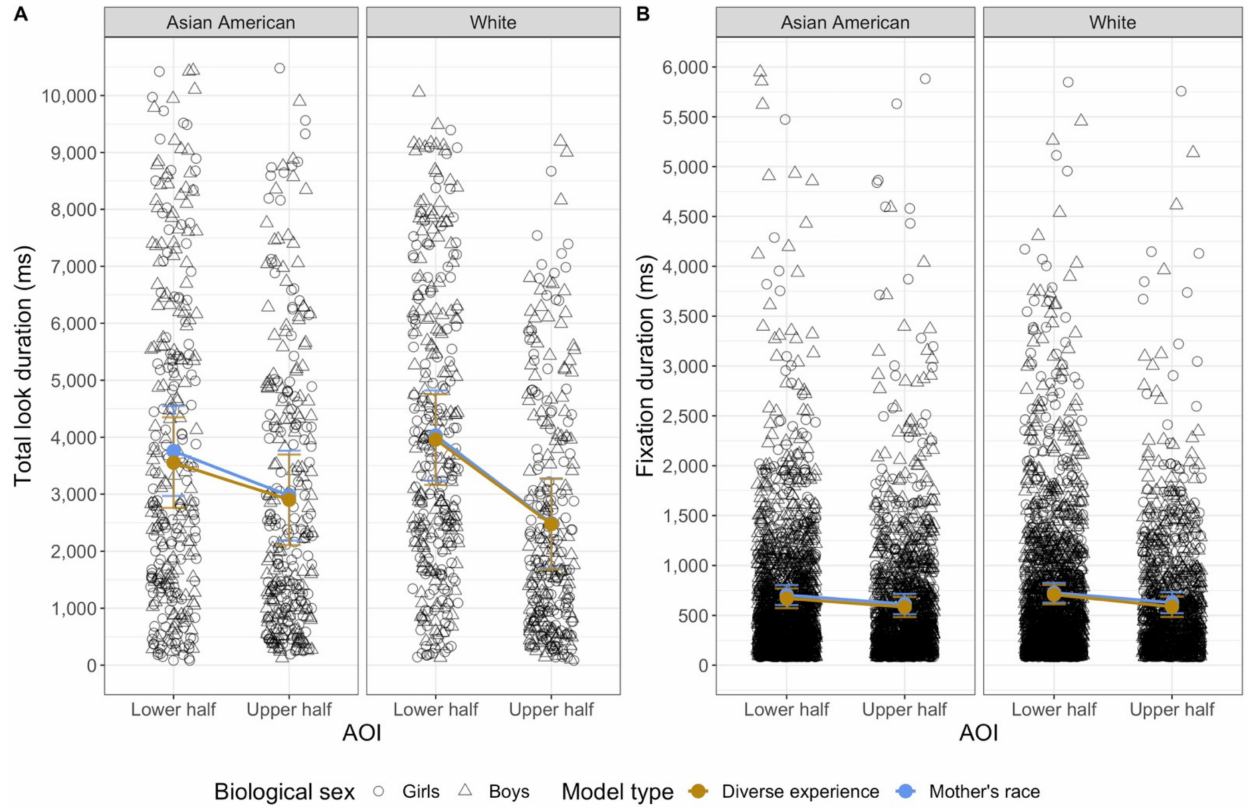
Figure 5. Duration of ( A ) total looking on each trial and ( B ) of individual fixations on each trial to the upper and lower regions, separated by Asian American and White faces. Each open circle is the duration on a single trial from a single infant ( A ) or a single fixation on a single trial from a single infant ( B ). The lines represent the estimated marginal means for each of the two models, and the error bars represent 95% Sidak-adjusted confidence intervals calculated from the models. Note, for clarity, the graph for the fixation durations does not include three fixations that were between 6000 and 8000 ms, but those fixations were included in the model. The biological sex of each infant is indicated by the shape of the